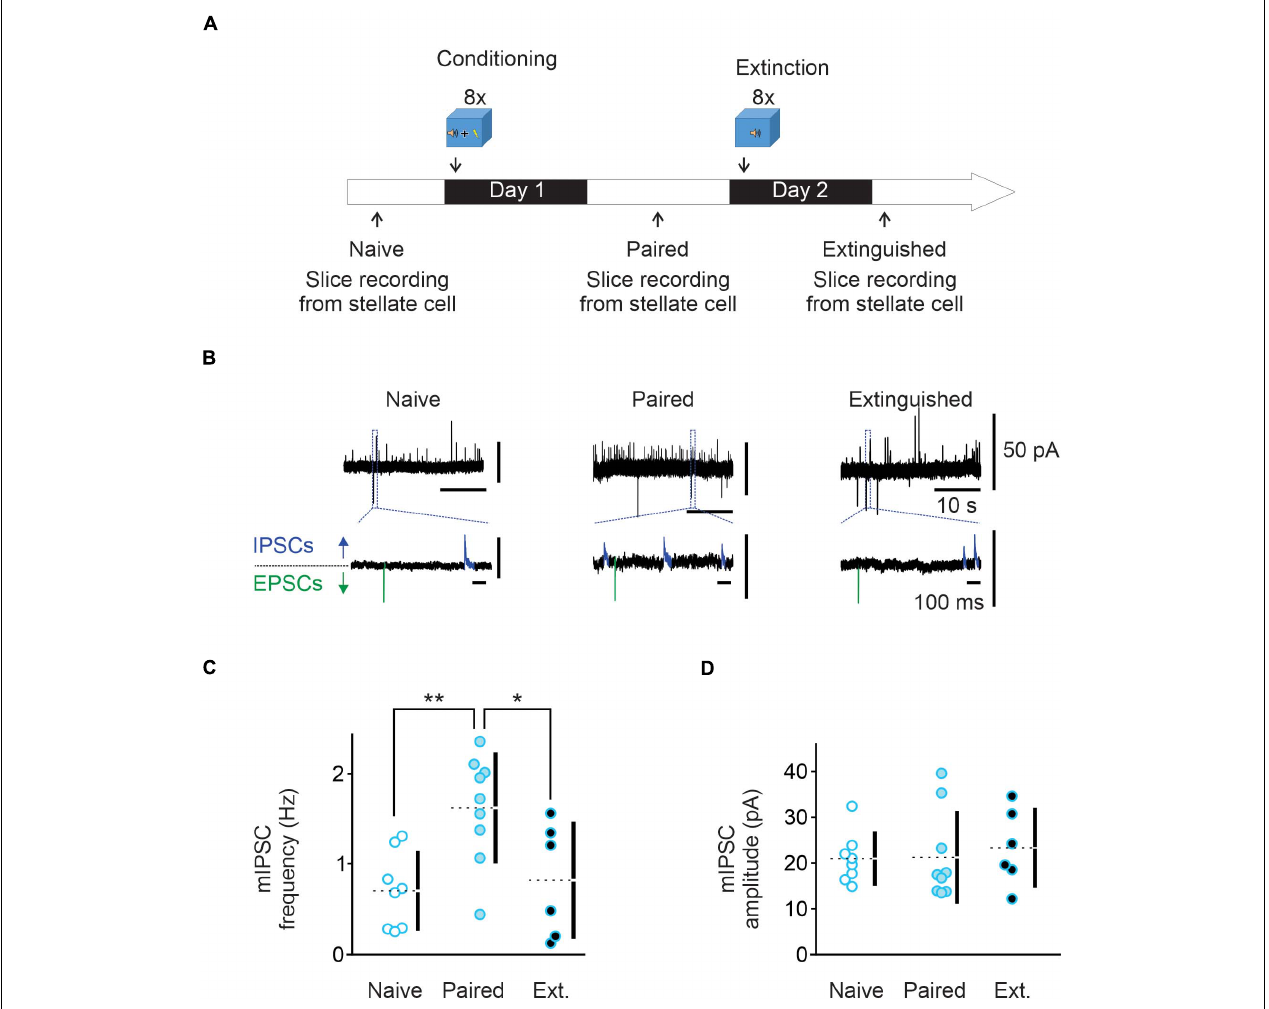
FIGURE 1 | Fear conditioning enhances and extinction learning reduces spontaneous GABA release from cerebellar molecular layer interneurons. (A) Conditioning protocol. Male mice ( n = 9) were habituated for 2 min in the conditioning chamber (context A) and exposed to eight pairings of a 10 s tone that co-terminated with a 1 s foot-shock (paired animals). Mice were left in the conditioning chamber for another 2 min before being returned to their home cage. Cerebellar slices were prepared and electrophysiology experiments were performed 15 h later. A subset of Extinguished mice ( n = 6) were exposed to eight tones alone 24 h after fear conditioning protocol. Cerebellar slices were prepared and electrophysiology experiments were performed 15 h later. (B) Representative traces recorded in putative stellate cells from the three behavioral groups at -30 mV. The bottom traces are enlargements of regions designated by the dashed lines. In these traces, outward IPSCs are highlighted in blue while inward EPSCs are shown in green. (C,D) Individual frequency and amplitude of the recorded mIPSCs from the three behavioral groups. Mean values are represented as doted lines. * P < 0.05; ** P < 0.01. Statistical analysis values can be found in the Supplementary Table 1